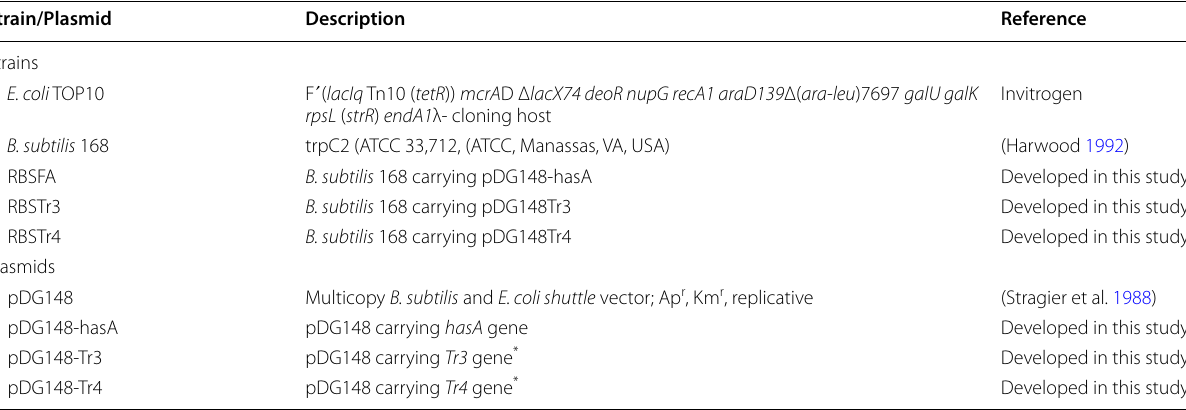
* Tr is truncated gene/protein